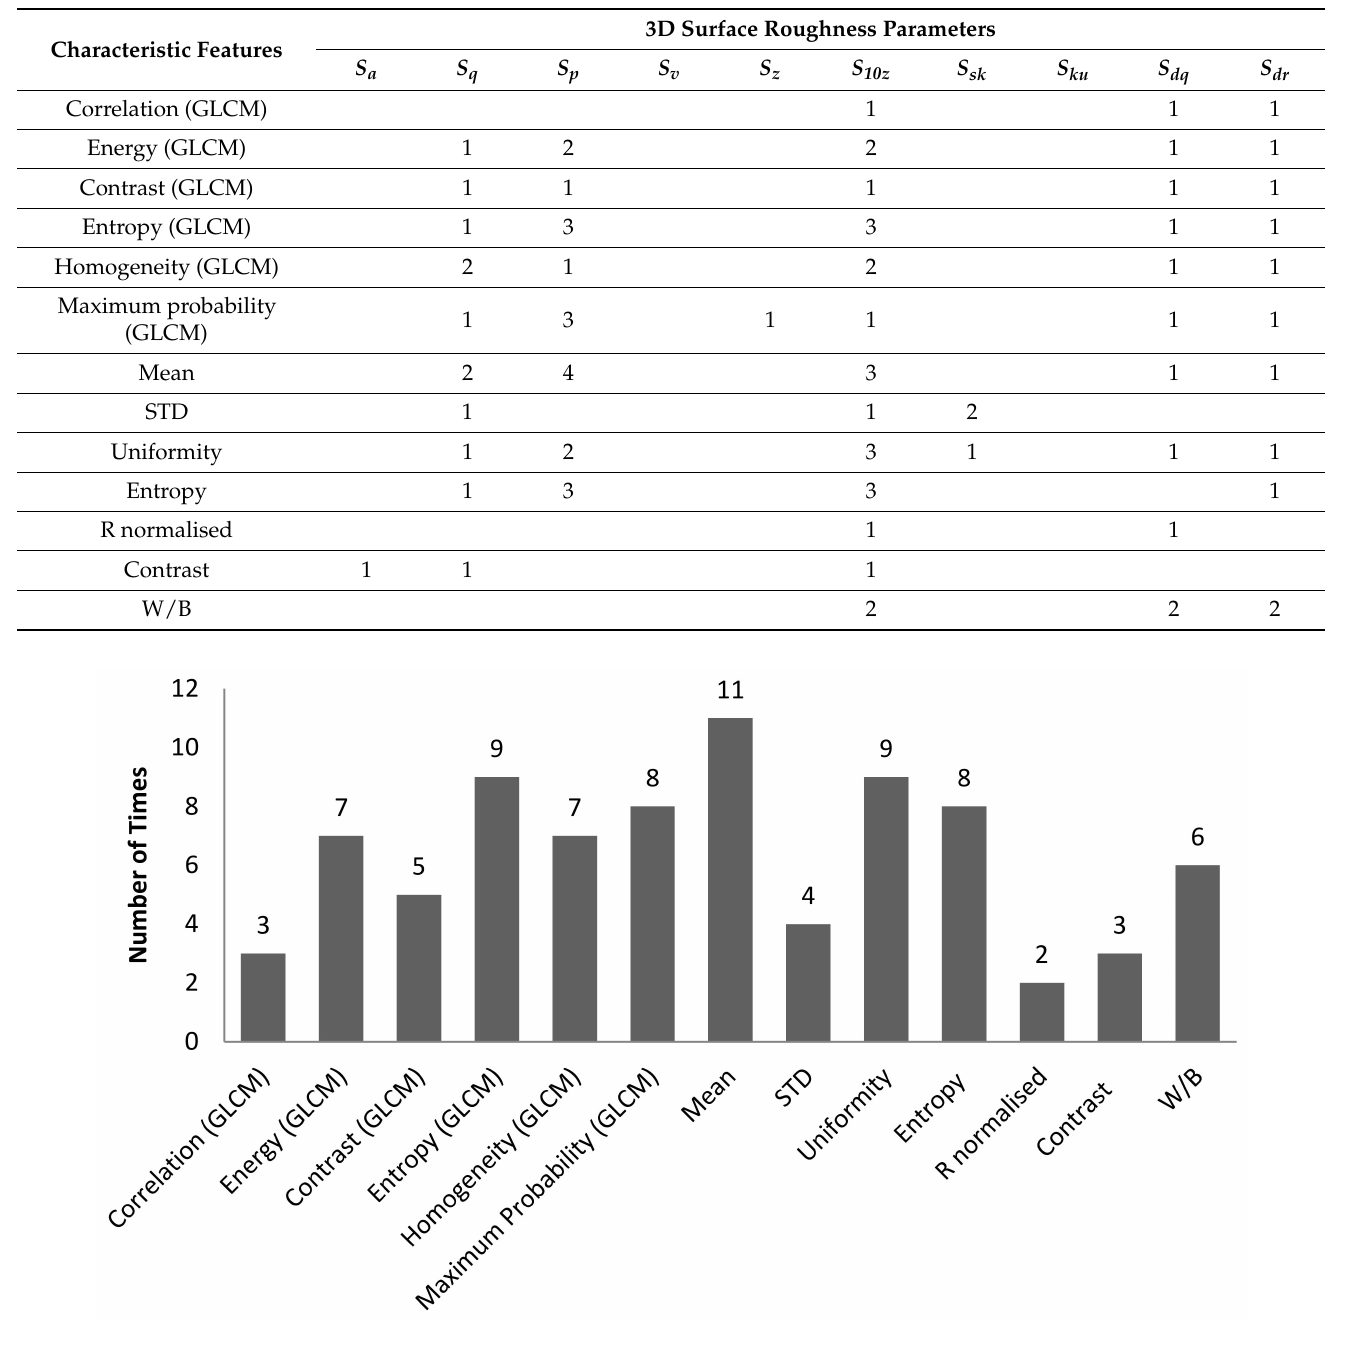
Figure 14. Bar chart showing the number of times a characteristic feature was involved in correlation with R 2 ≥ 0.7 for an illumination angle of 60 ◦ for experimental setup